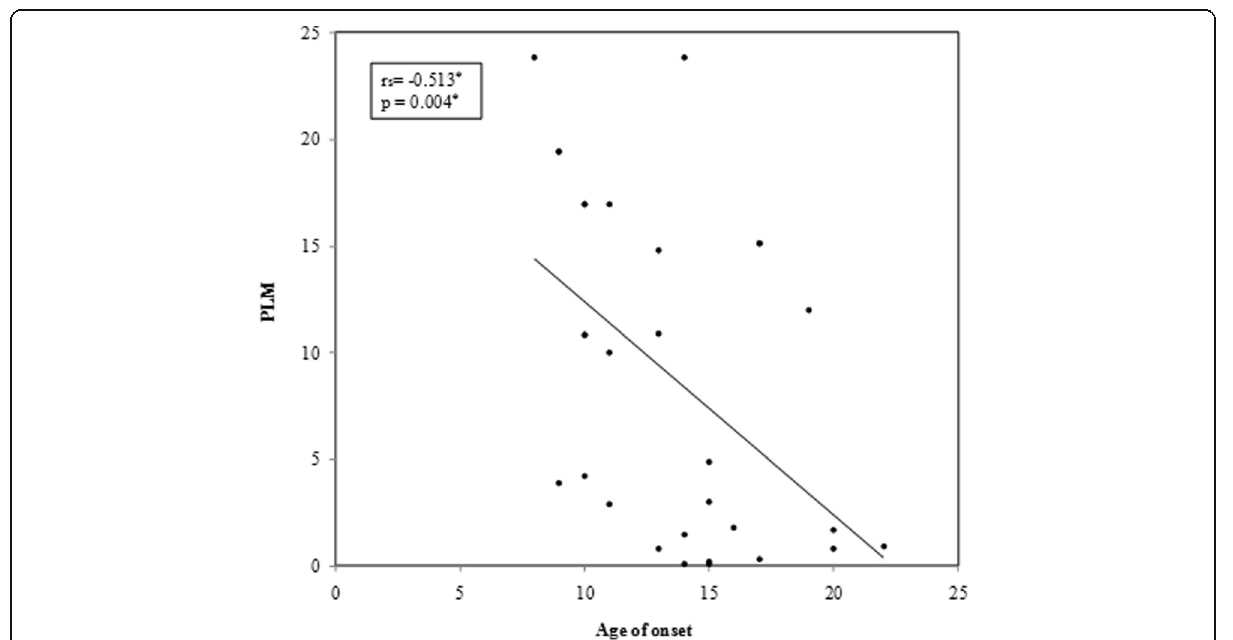
Fig. 2 Correlation between age at onset of epilepsy and periodic limb movement